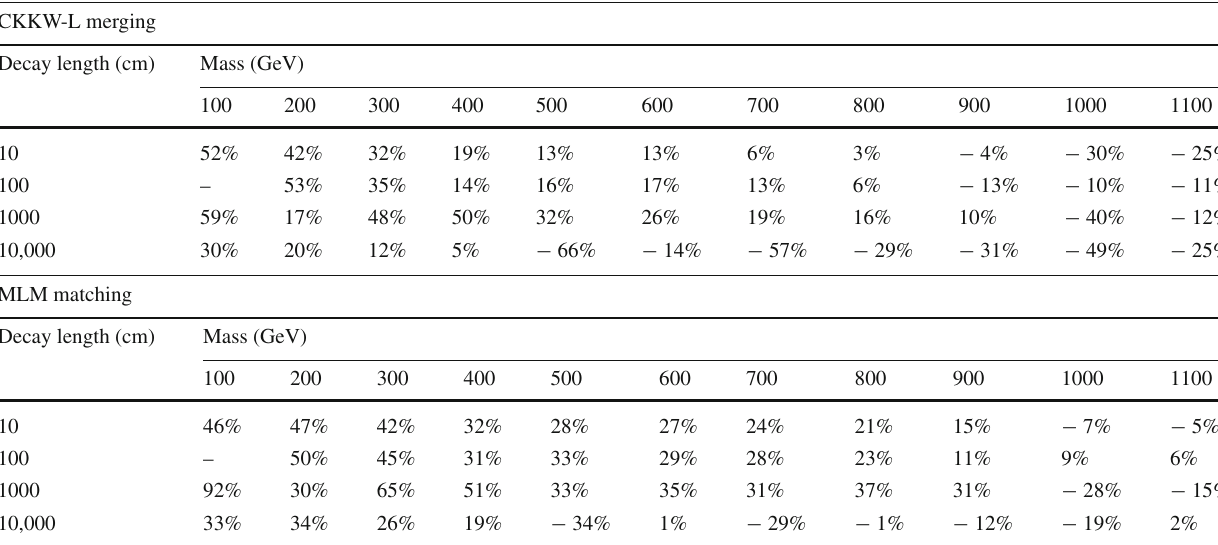
Table 5 Errors for chargino-chargino events. Top: using CKKW-L merging; Bottom: using MLM matching CKKW-L merging Decay length